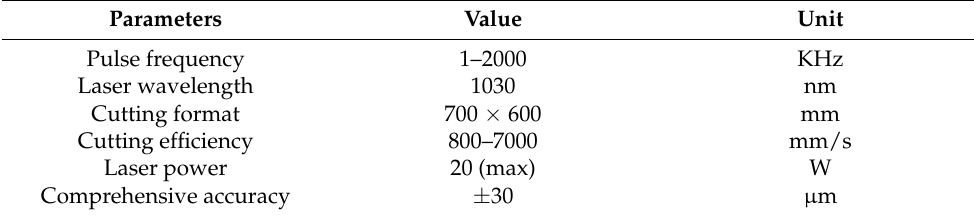
Table 2. Specific parameters of femtosecond-laser equipment.